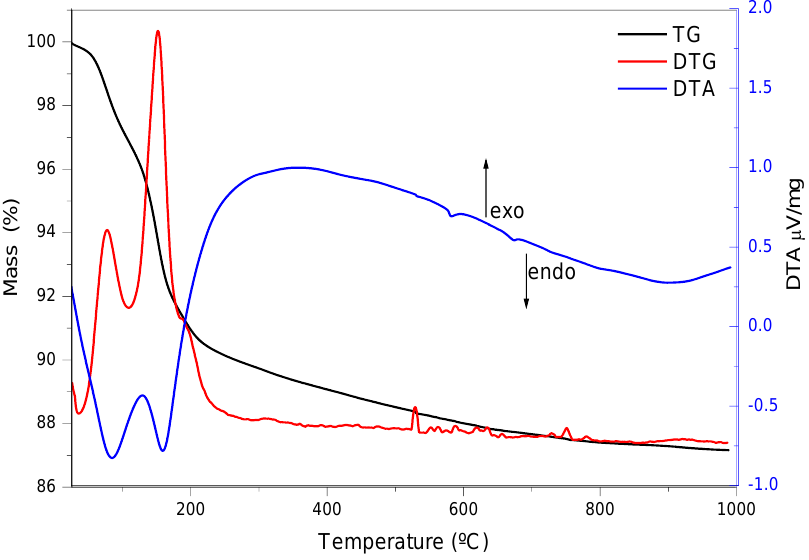
Figure 4. TG and DTA obtained for Zn-AlPO 4 under an oxidizing atmosphere at a heating rate of 20 20 ◦ C min − 1 °C min − 1 .